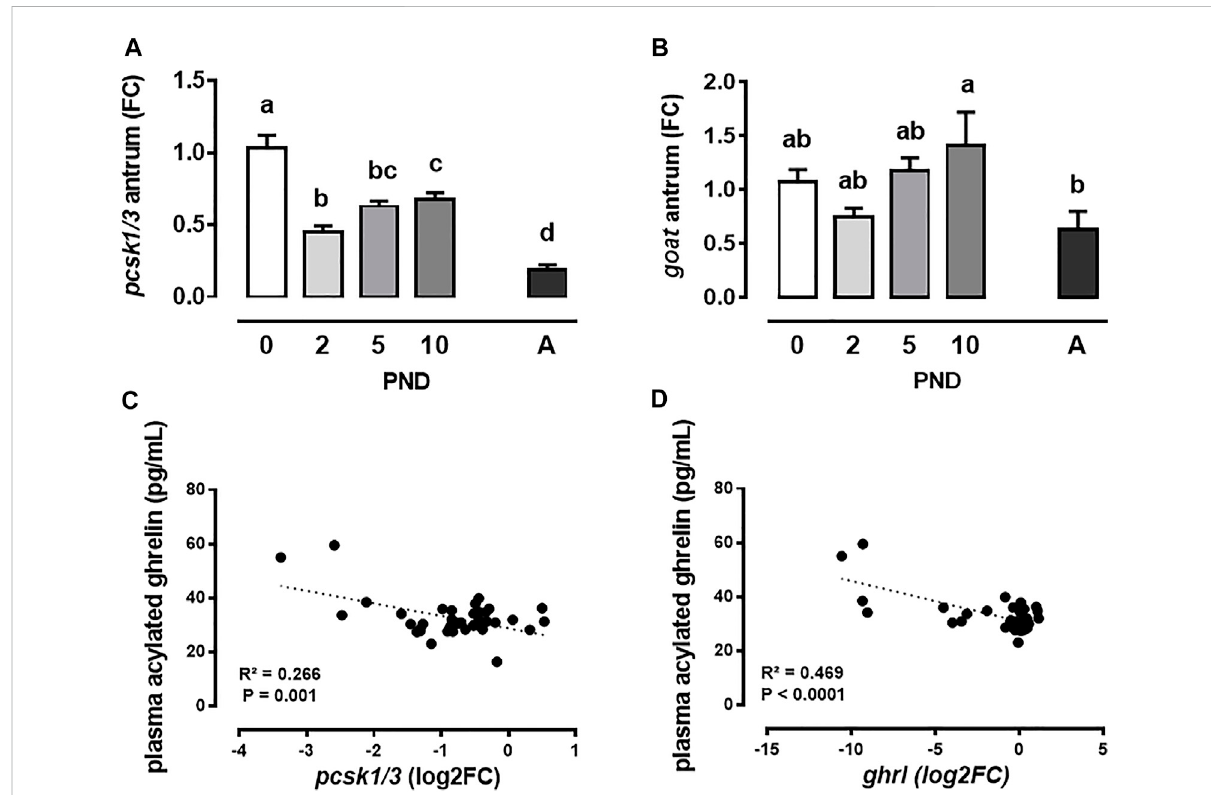
FIGURE 2 Neonatal development of ghrelin maturation enzymes in mini-pigs. Convertase 3 ( pcsk 1/3) (A) and ghrelin-O-acetyl transferase ( goat ) (B) mRNA levels in the antrum were measured in neonatal suckled mini-pigs (post-natal days (PND) 0 – 10) and in adult ones (A) . Pearson correlation between pcsk 1/3 (C) or goat (D) mRNA levels in the antrum and plasma acylated